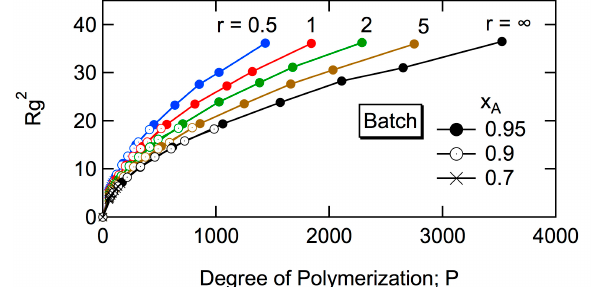
Figure 12. Relationship between Rg 2 and P with various r -values at x A = 0.95 (filled circle), 0.9 (open circle), and 0.7 (cross) for batch polymerization.